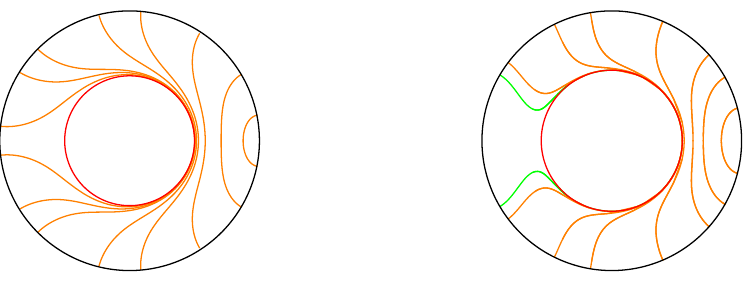
Figure 4. Connected minimal surfaces. Left: d = 3, g = (cid:22) = (cid:12) = G = 1 and (cid:13) = (cid:0) 0 : 1. Right: d = 4, g = (cid:12) = G = 1, (cid:13) = (cid:0) 0 : 1 and (cid:22) = 2 :